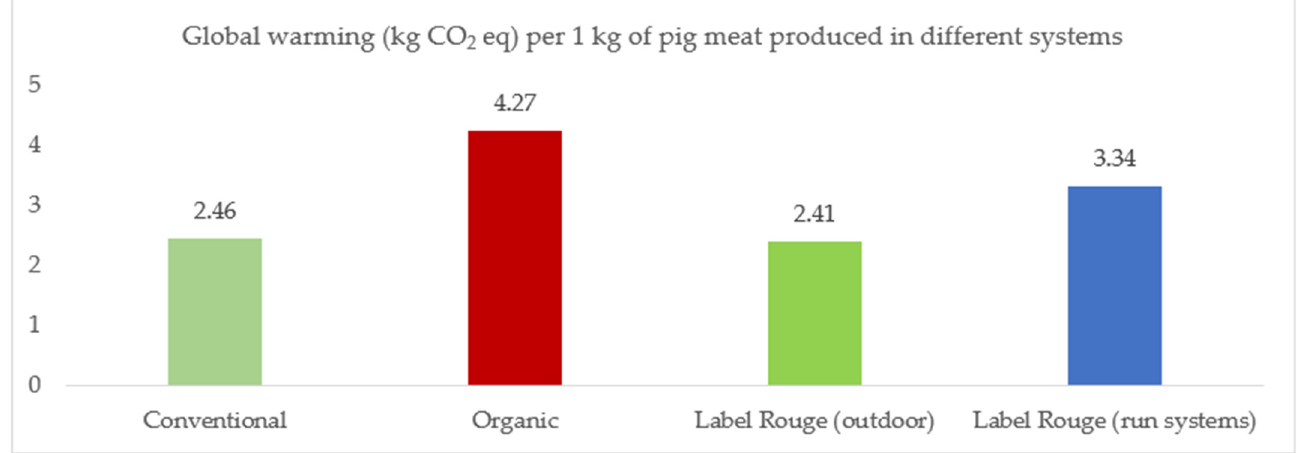
Figure 4. Global warming per 1 kg Pig meat across organic, Label Rouge and Conventional systems: Data obtained from AGRIBALYSE ® database and computed using OpenLCA 1.10.2 [35,36].